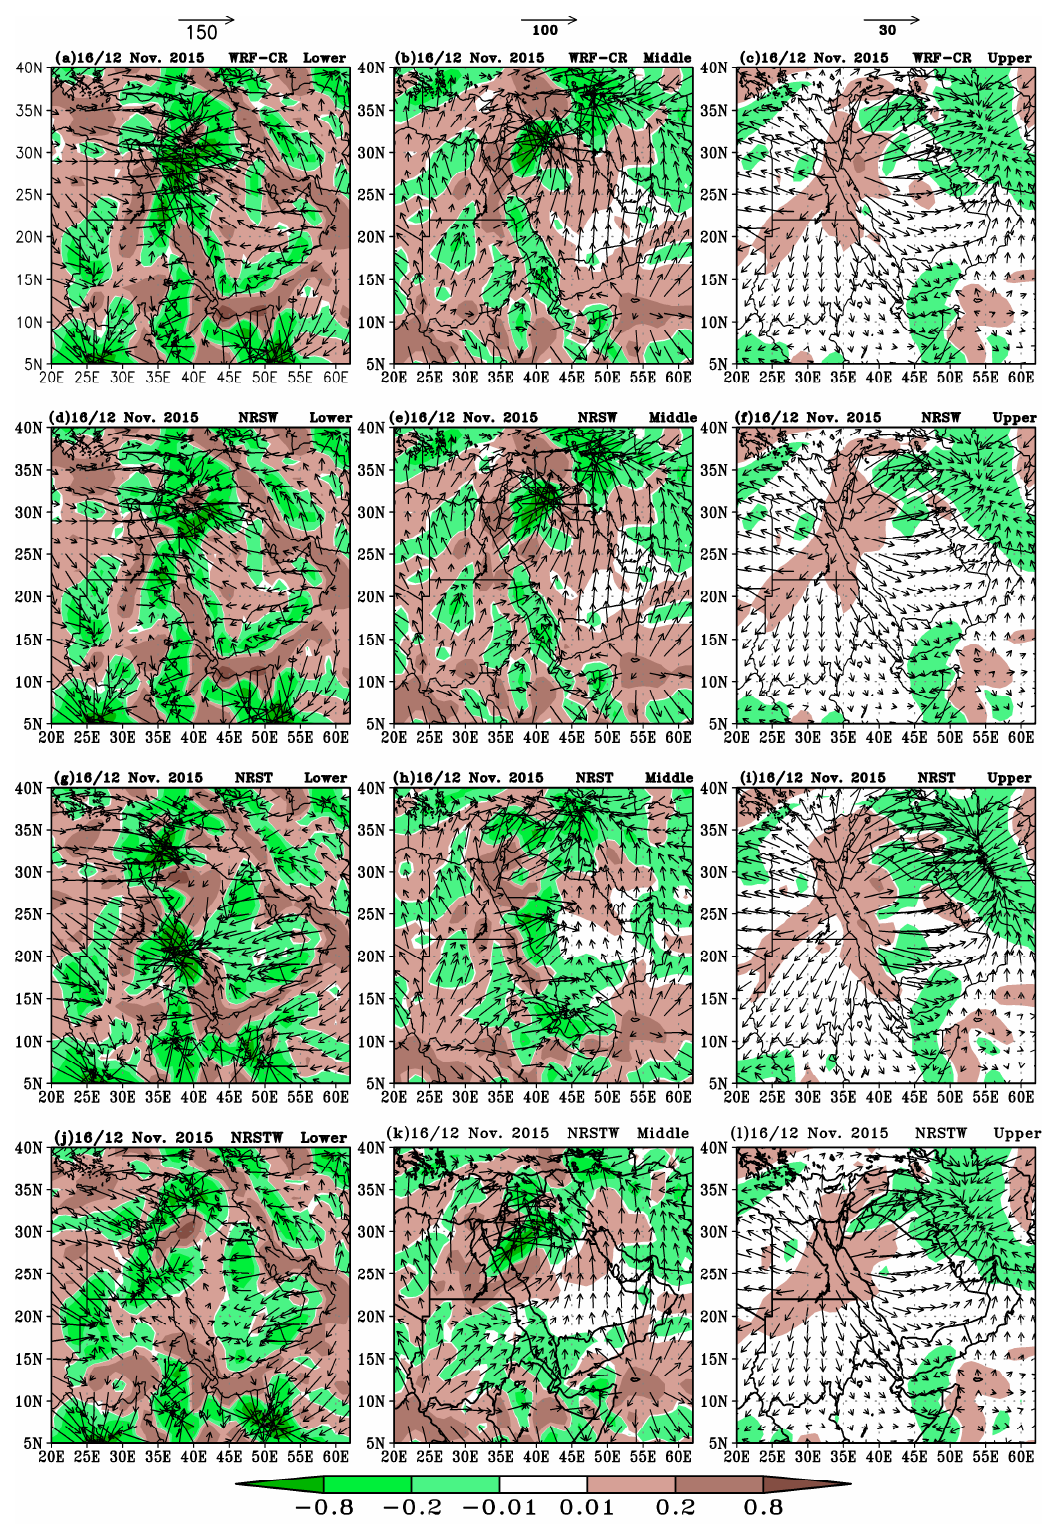
Figure 13. Divergent component of integrated moisture-flux vector for WRF-CR ( a , b , c ), NRSW ( d , e , f ), NRST ( g , h , i ), and NRSTW ( j , k , l ), and the colored regions are the divergent (source) and convergent (sink) component of the moisture flux (10 − 3 kg m − 2 s − 1 ) in three tropospheric layers: the lower with 1000–850 hPa ( a , d , g , j ), the middle with 700–500 hPa ( b , e , h , k ), and the upper layer with 400–100 hPa ( c , f , i , l ) for 12Z of 16 November 2015.